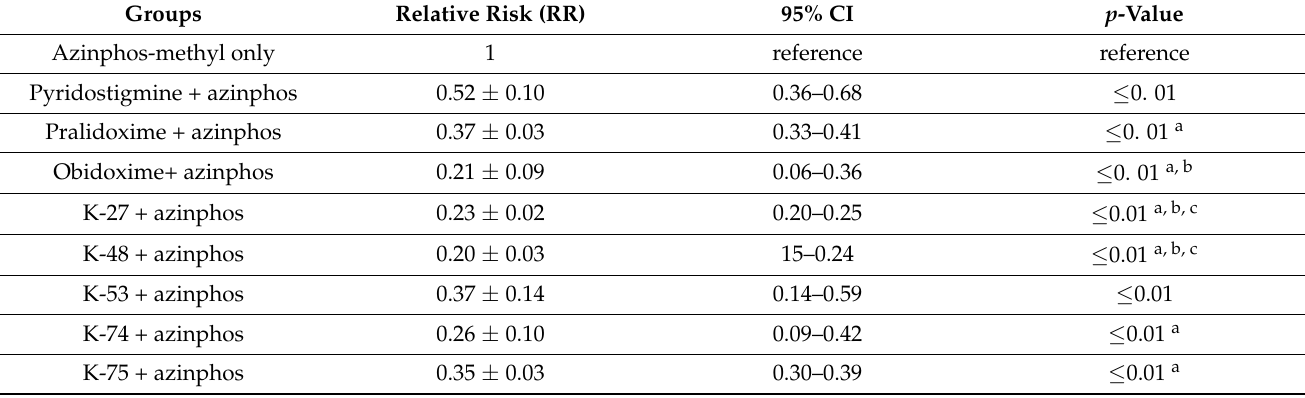
Table 3. Survival analysis [42] of the cumulative relative risk (RR) of death, including 95% confidence interval (CI), of animals injected with azinphos-methyl (5, 10 or 15 µ mol) intraperitoneally (i.p.). Values are adjusted for azinphos-methyl dose (high/low). The cumulative RR was assessed by determining the area under the RR-time curve (see Figure 1) for pre-exposure treatment with pyridostigmine, pralidoxime, obidoxime, K-27, K-48, K-53, K-74, or K-75. The injected dose was approximately 1 of the LD 01 . Group 1, i.e., only azinphos-methyl and no pretreatment, was the reference category (RR = 1). 4 Listed are mean values ± standard deviations (SD). Statistical differences relative to the reference group (only azinphos- methyl and no pretreatment) were tested by the Mann-Whitney U-Test, and a p value ≤ 0.05 was considered significant. a : mortality significantly decreased compared with pyridostigmine; b : mortality significantly decreased compared with pralidoxime; c : mortality significantly decreased compared with